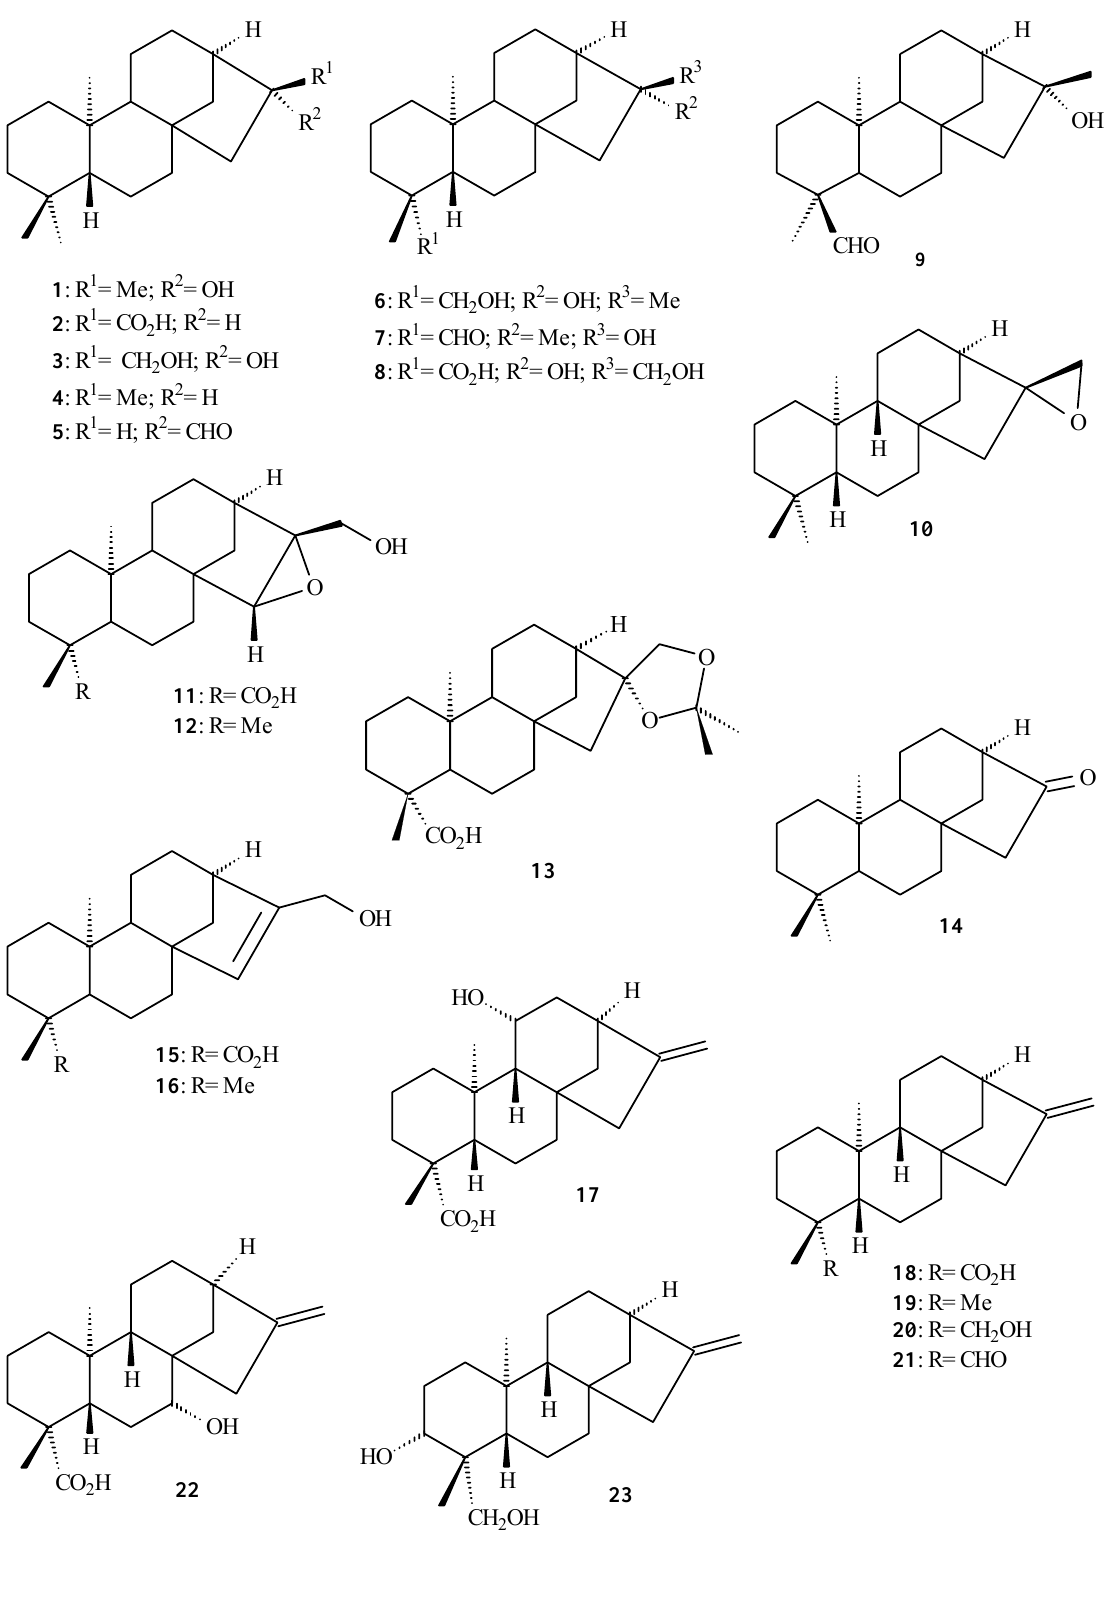
Figure 2. Kaurane diterpenoids isolated from Aristolochia